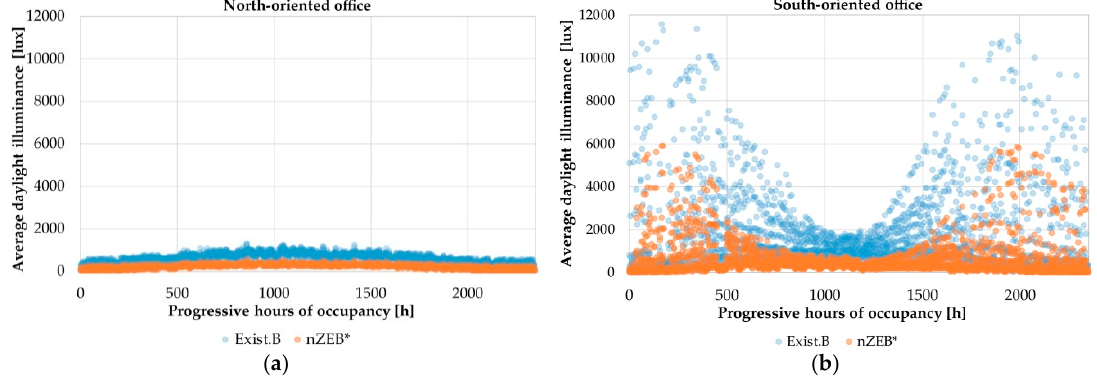
Figure 6. Comparison of the average hourly values of daylight illuminance for the occupied hours over the whole year between the building in the present configuration (Exist.B) and after retrofitting